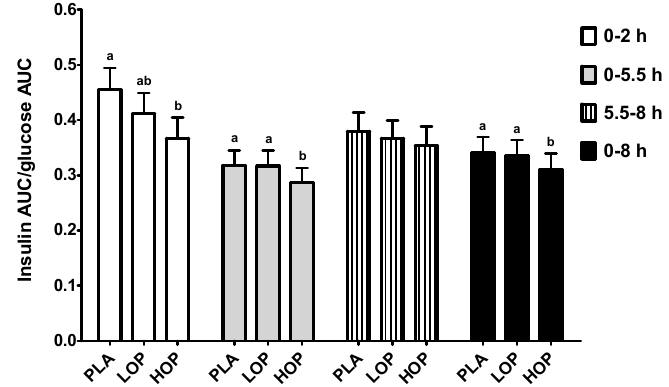
Figure 4. The ratio of the serum insulin area under the concentration-time curve (AUC) to the serum glucose AUC in the subjects consuming one of three study beverages, placebo (PL), Low (LOP), and High (HOP), along with a high fat and carbohydrate breakfast and a high fat and carbohydrate lunch after the 5.5-h blood draw. a,b Means at the same time point without sharing the same letter differ, tested by the general linear mixed effects model, followed by the Tukey HSD multi-comparison test, p ≤ 0.05.